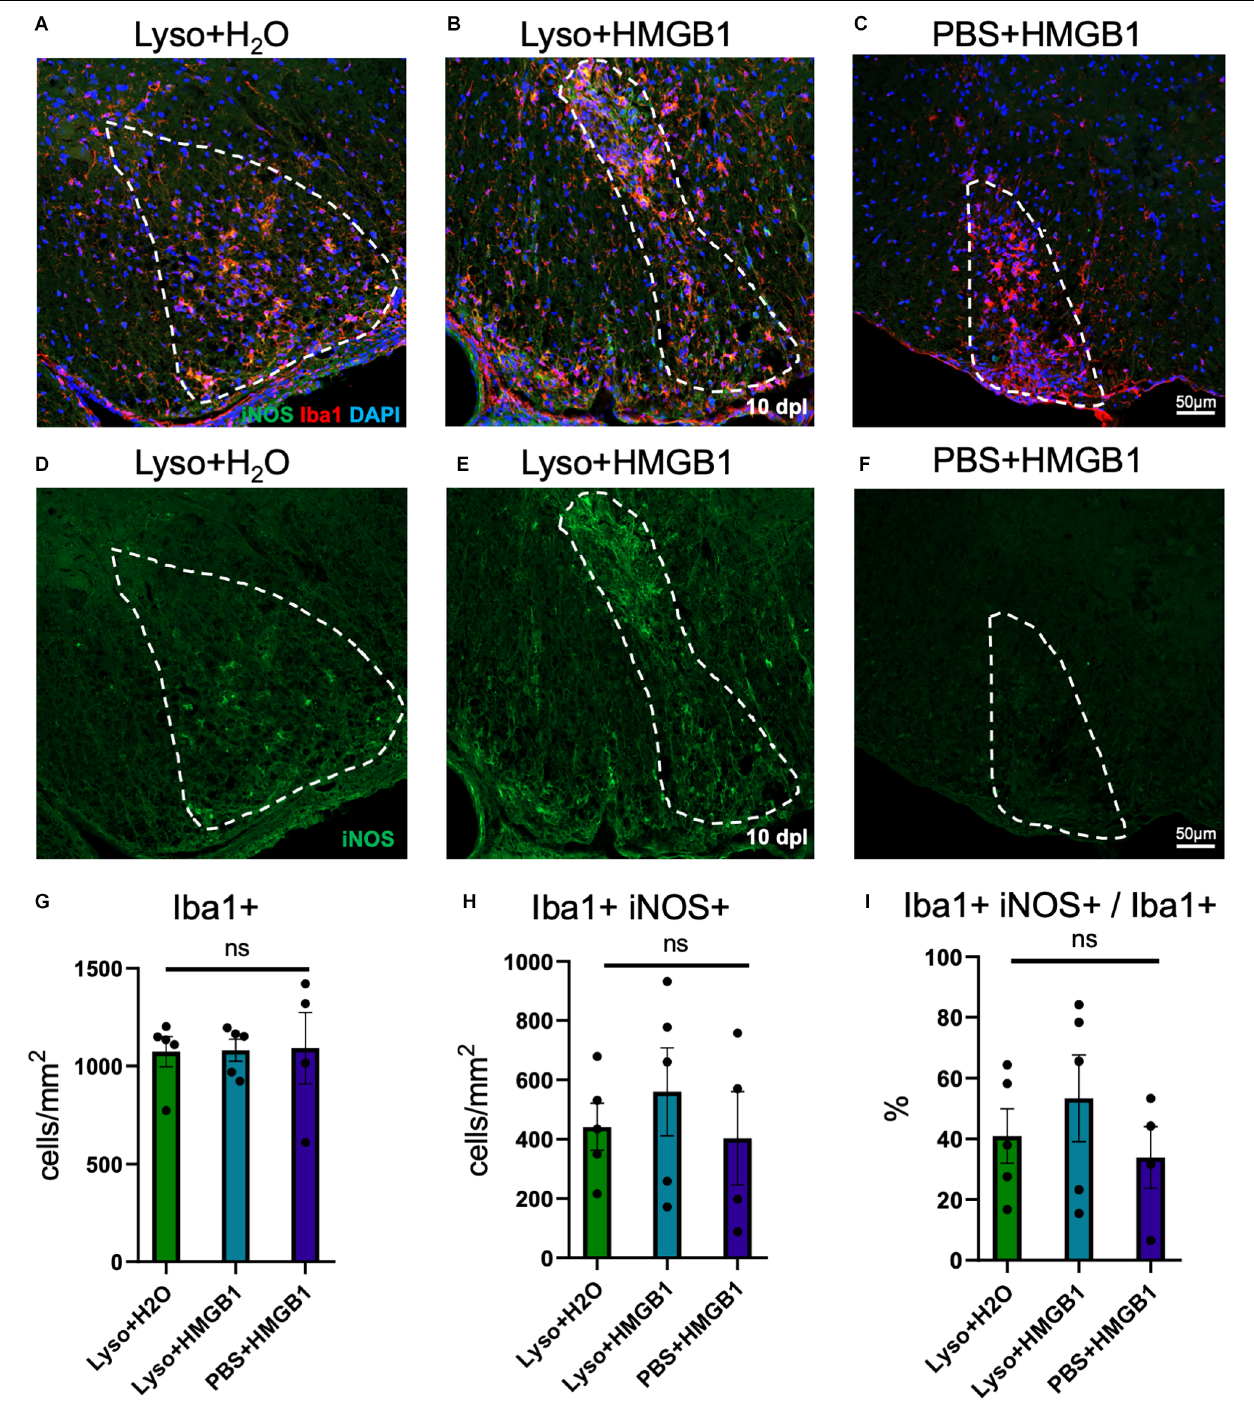
FIGURE 3 | HMGB1 treatment did not increase inflammation within demyelinated lesions. (A) A representative IHC image of mouse spinal cord injected with 1 µ l LPC (1.0%) and water control 10 dpl stained with iNOS, Iba1, and DAPI. (B) A representative IHC image of mouse spinal cord co-injected with 1 µ l LPC (1.0%) and 1 µ l rhHMGB1 (1 mg/ml in water) at 10 dpl stained with iNOS, Iba1, and DAPI. (C) A representative IHC image of mouse spinal cord injected with 1 µ l rhHMGB1 (1 mg/ml in water) 10 days post injection stained with iNOS, Iba1, and DAPI. (D – F) Single channel images of iNOS immunostaining of samples represented in panels (A – C) . Lesion areas are represented by dashed white lines. (G) Quantification of Iba1+ cells. (H) Quantification of Iba1+ and iNOS+ cells. (I) Percent of Iba1+ cells that were also iNOS + . White dashed lines indicate lesion/injection site. Two to six spinal cord sections from each mouse were used for quantification, 3–5 mice per condition. ns when P > 0.05. Scale bar = 50 µ